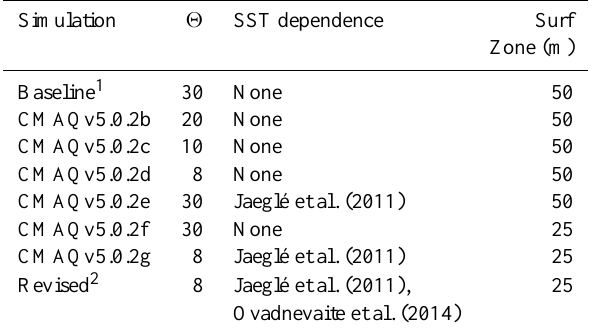
Table 1. Differences in the CMAQ model versions used in this